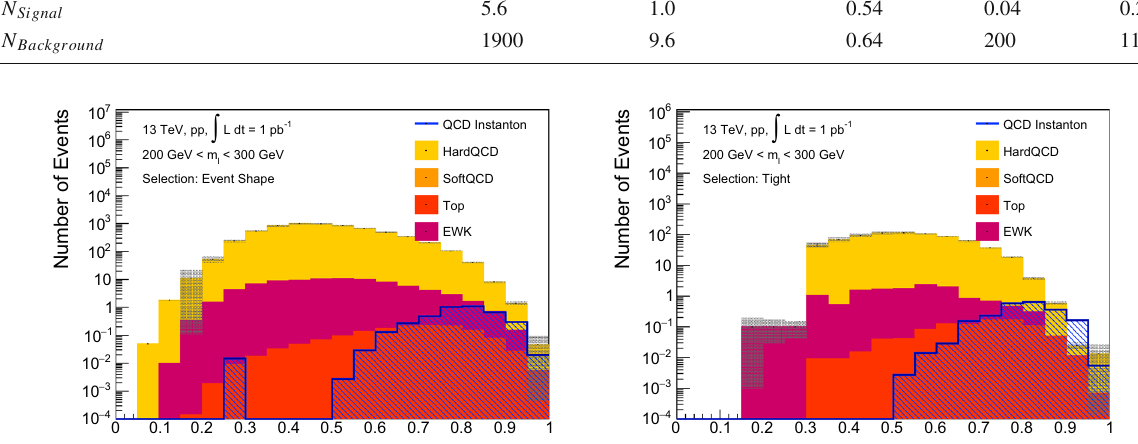
(cid:8) 1pb − 1 for the event-shape based selection (left) and the tight selection